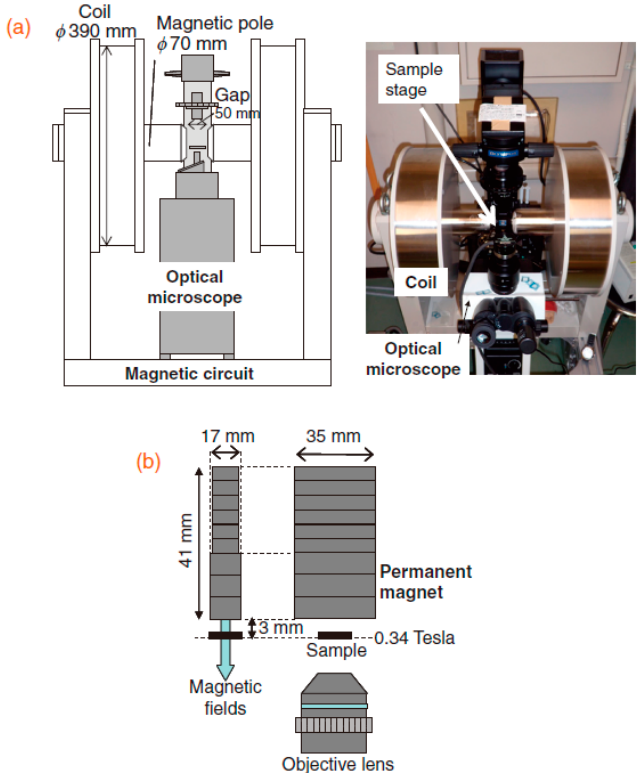
Figure 1. Experimental setup utilized to observe the orientation of crystal boards: ( a ) horizontal magnetic field generated by an electromagnet; and ( b ) vertical magnetic field generated by a permanent magnet [15]. Reproduced from reference [15] with permission from the Japan Society of Applied Physics.